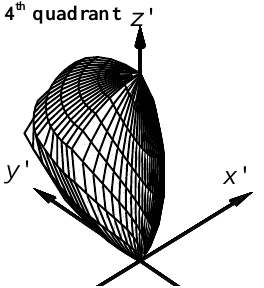
Figure 2. Normalized 3-D channel gain of the 4 th quadrant of the QADA receiver. The gain of the other three quadrants will look similar, but ’point’ in different